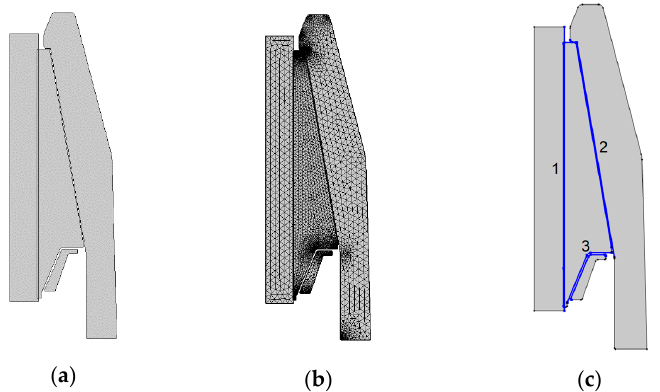
Figure 6. The geometry of the model is presented with: ( a ) geometry, ( b ) mesh, and ( c ) contact pair